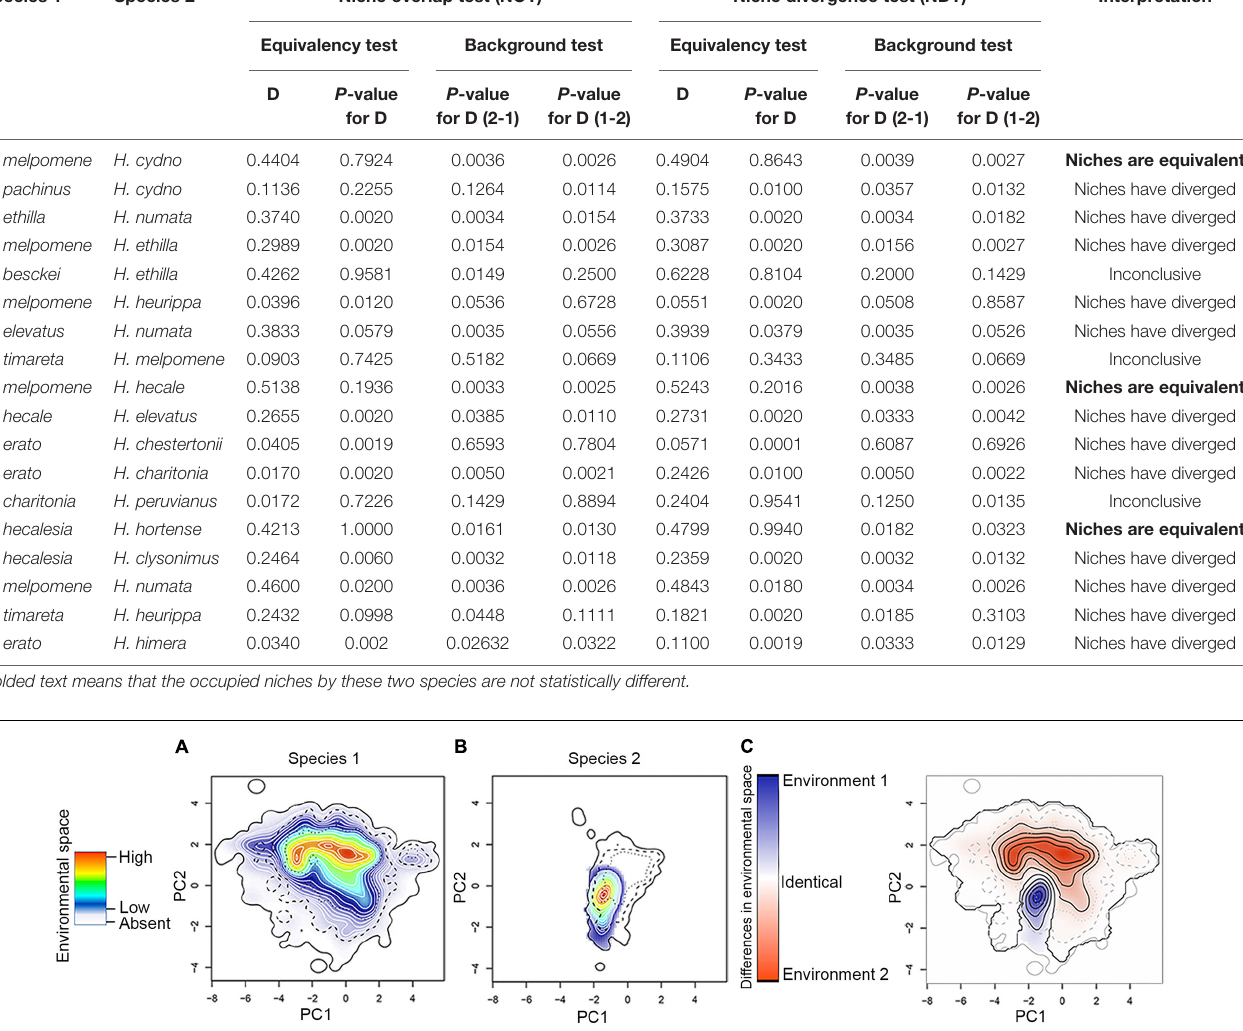
TABLE 1 | Niche overlap test (NOT) and niche divergence test (NDT) between hybridizing species. Species 1 Species 2 Niche overlap test (NOT)